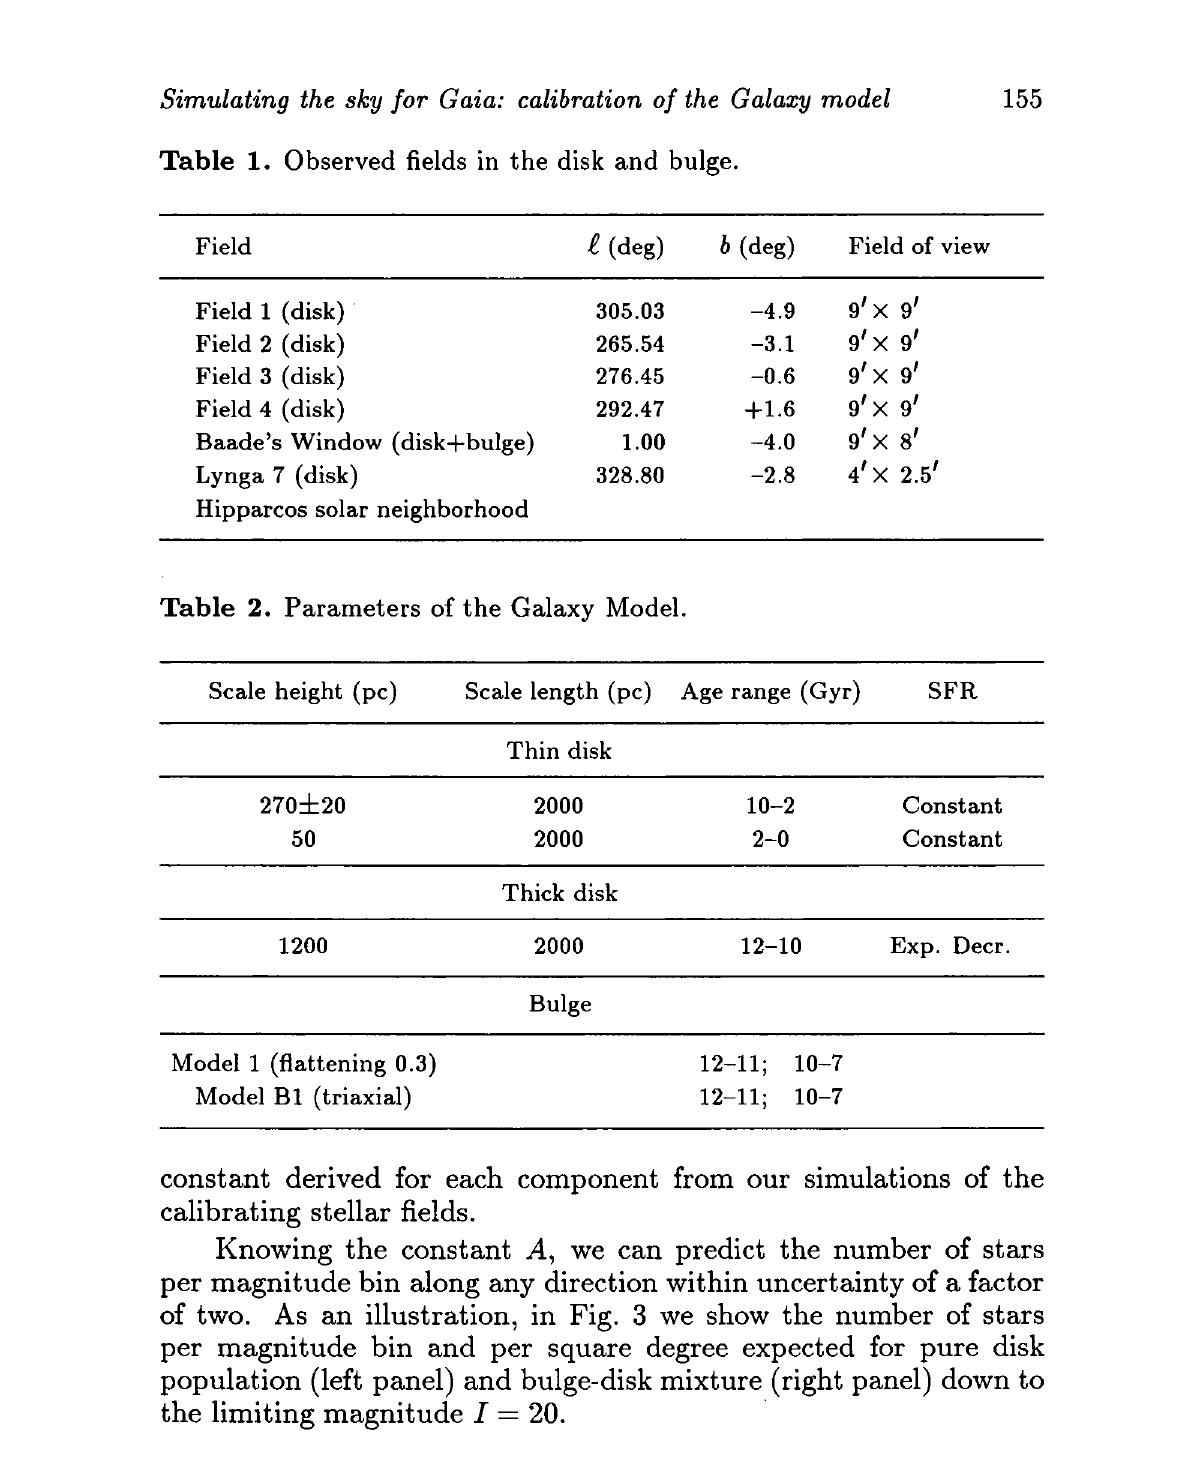
Table 2. Parameters of the Galaxy